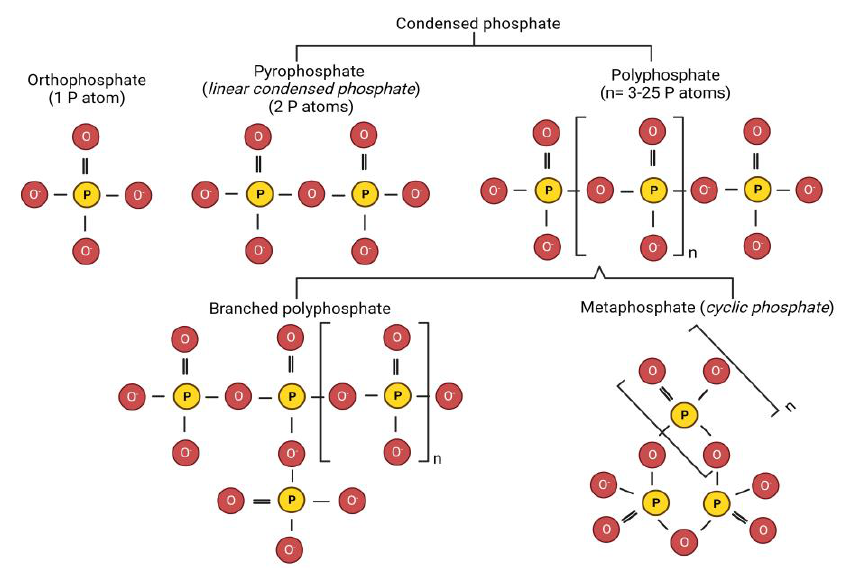
Figure 1. Molecular structure of different phosphate-based calcium sequestering salts used in processed cheese manufacture (P and O indicate phosphorus and oxygen atoms, respectively, whereas n represents the number of P atoms) (Created with BioRender.com, accessed on 13 February 2023).